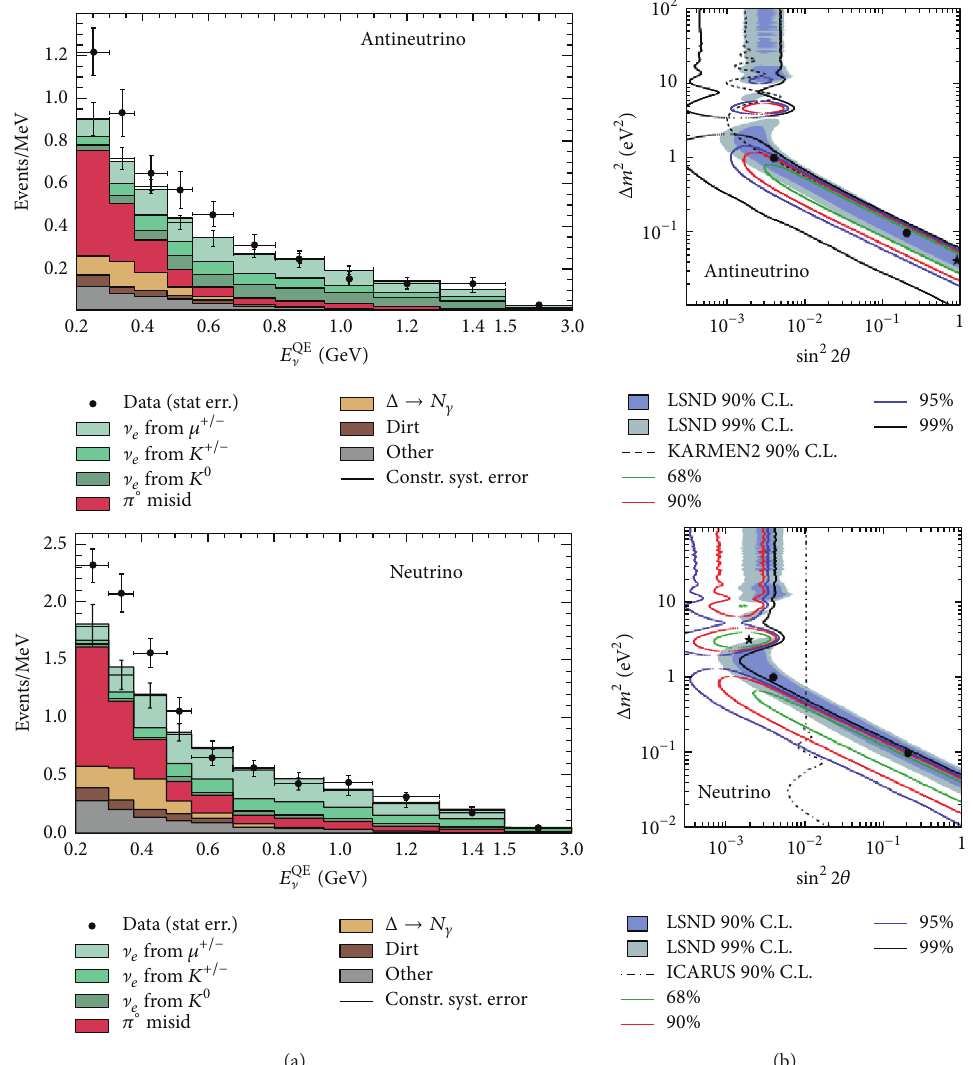
Figure 7: (Color online) The final MiniBooNE oscillation results [58]. (a) shows the reconstructed neutrino energy distribution of oscillation candidate events. The top is for antineutrino mode and the bottom is for neutrino mode. (b) shows the allowed region in Δ𝑚 2 − sin 2 2𝜃 , where the best fit points are shown in black